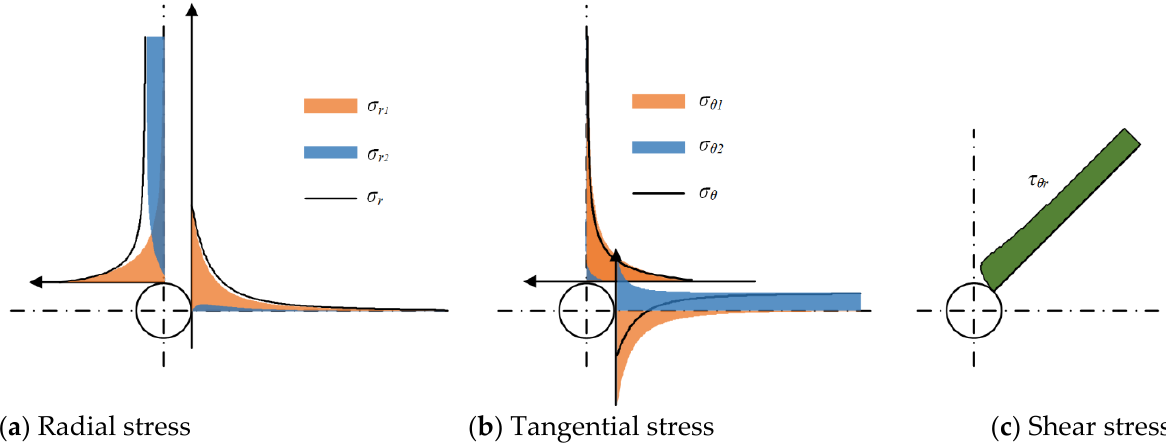
Figure 9. Stress characteristics around blasting borehole when lateral pressure coefficient is 0.